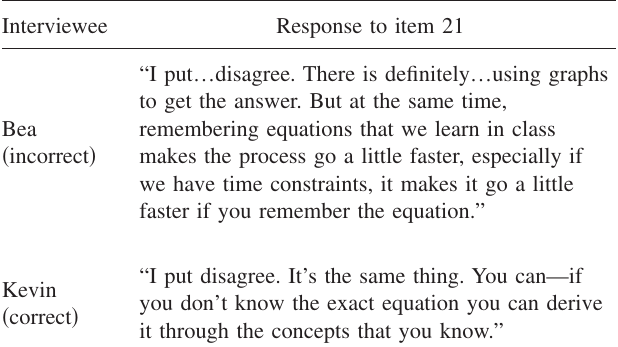
TABLE II. Interviewee responses from two different groups to the CLASS item 6 that differed from the intended meaning.